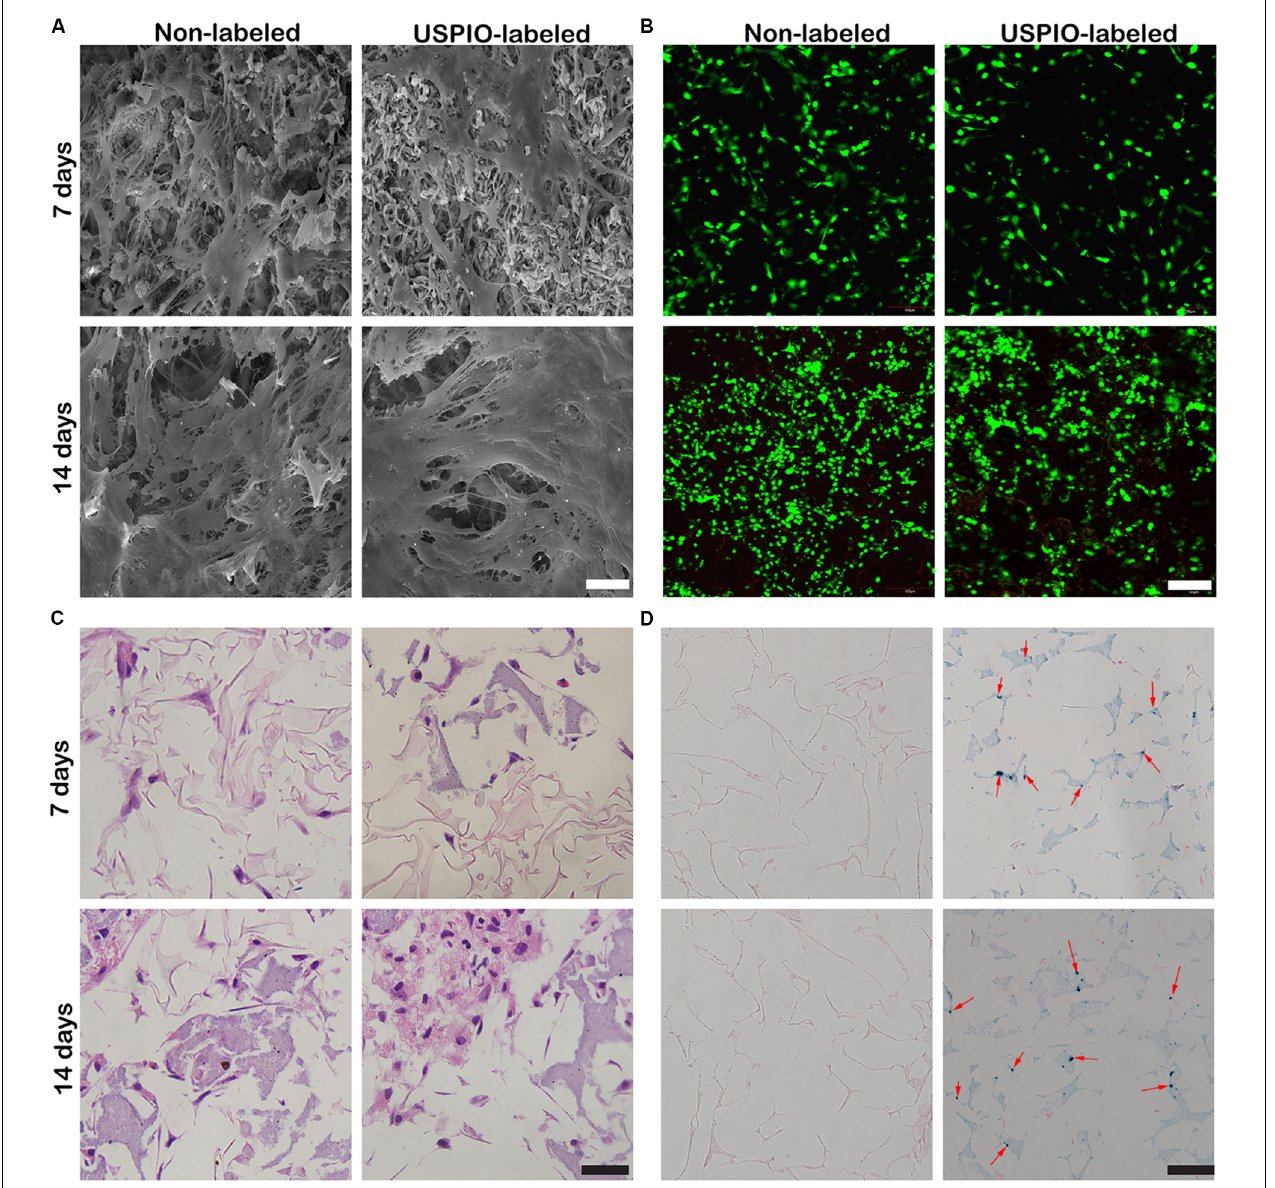
FIGURE 4 | Cell adhesion and growth cultured with USPIO-labeled and unlabeled scaffolds at 7 and 14 days. (A,B) SEM and Live/Dead staining show BMSCs adhered to scaffolds. Scale bar indicates 40 µ m for SEM and 100 µ m for Live/Dead staining. (C,D) H&E and Prussian staining of scaffold composites. Scale bar indicates 50 µ